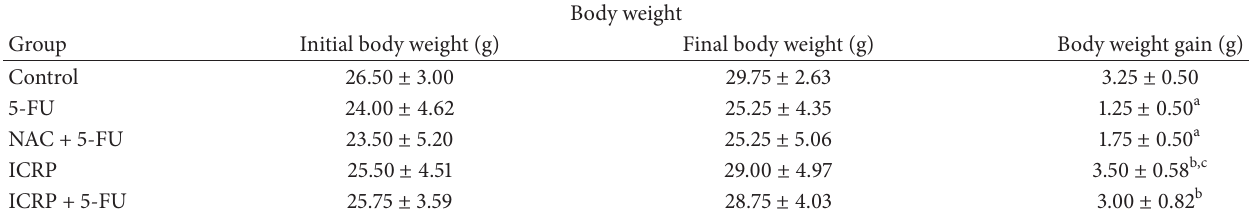
Table 4: Effects of 5-FU, NAC + 5-FU, ICRP, and ICRP + 5-FU on body weight gain in treated mice. Body